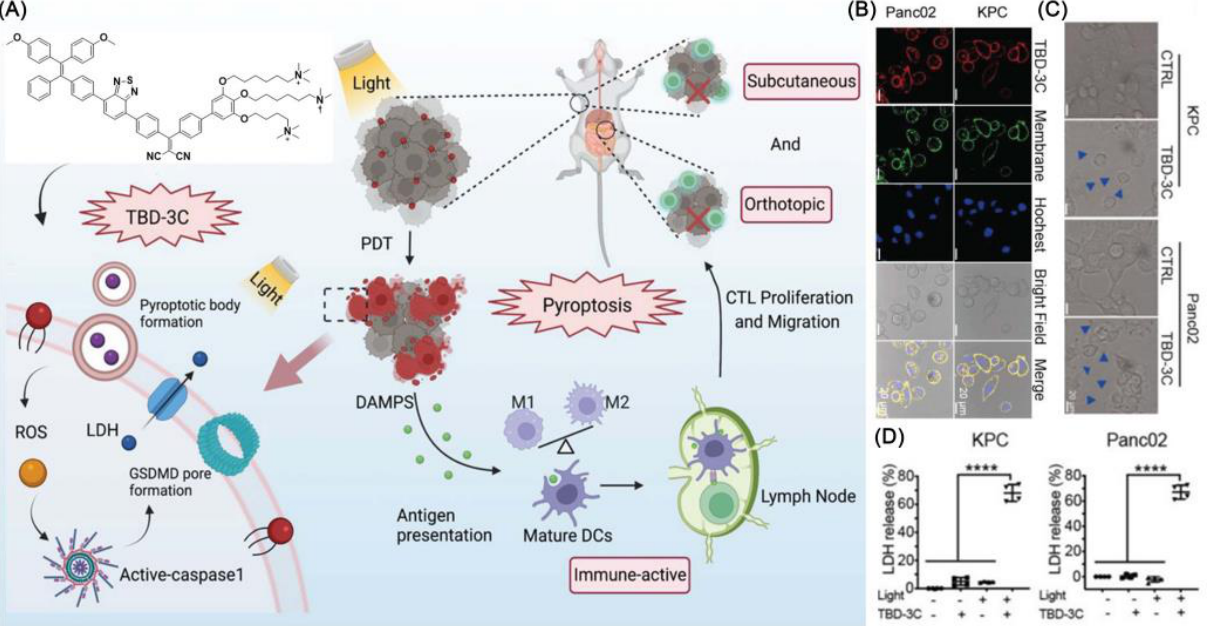
Figure 3. ( A ) Photodynamic pyroptosis for antitumor immunotherapy; ( B ) images of cells incubated